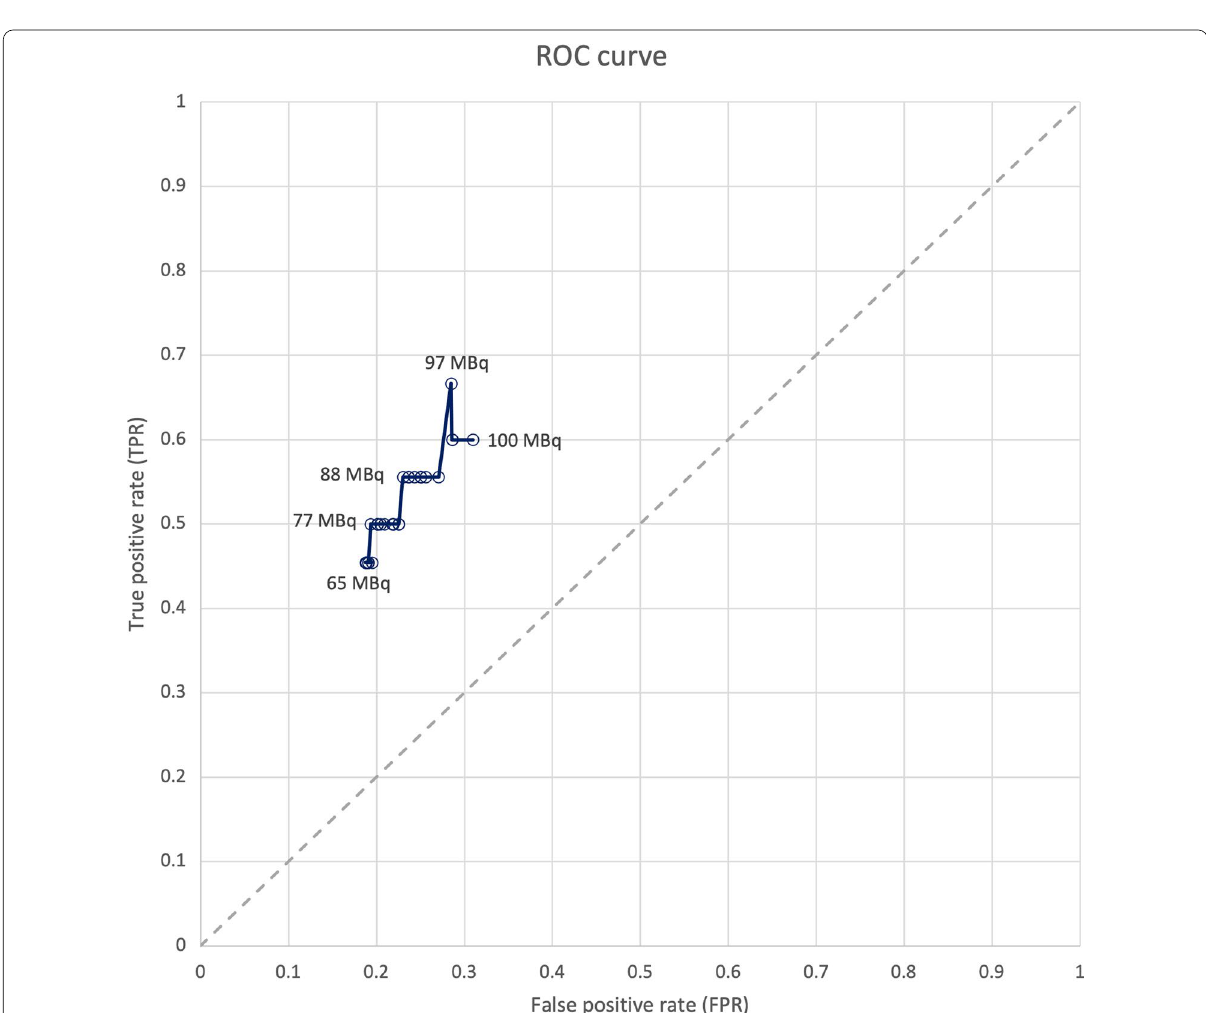
Fig. 4 Receiver operator curve (ROC) of intraoperative FAR performance on intact WLE specimen for various decay corrected injected [ 18 F]FDG activity thresholds with increments of 1